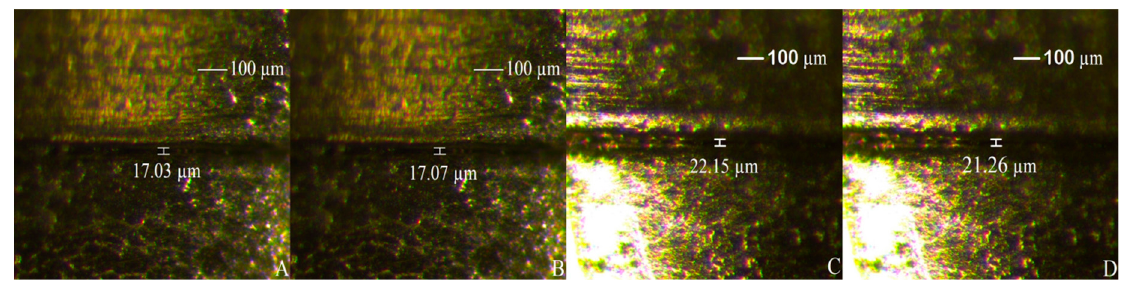
Figure 3. Implant–abutment misfit: SCREW (control ( A )) specimen with original prosthetic screws and rSCREW group ( B ). PTFE ( C ) and rPTFE group ( D ) specimen with screws wrapped in PTFE tape.